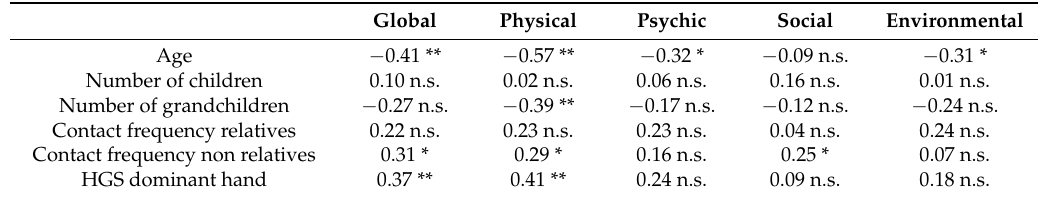
Table 4. Spearman correlations between domains and sociodemographic parameters as well as had grip strength (rho).